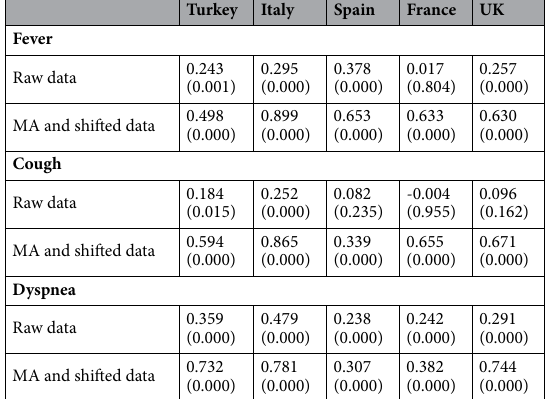
Table 1. Spearman correlations between symptoms and new cases. Notes: Symptoms and cases are estimated with five days moving average, and symptoms are shifted with days with minimum RMSE values. p-values are shown in